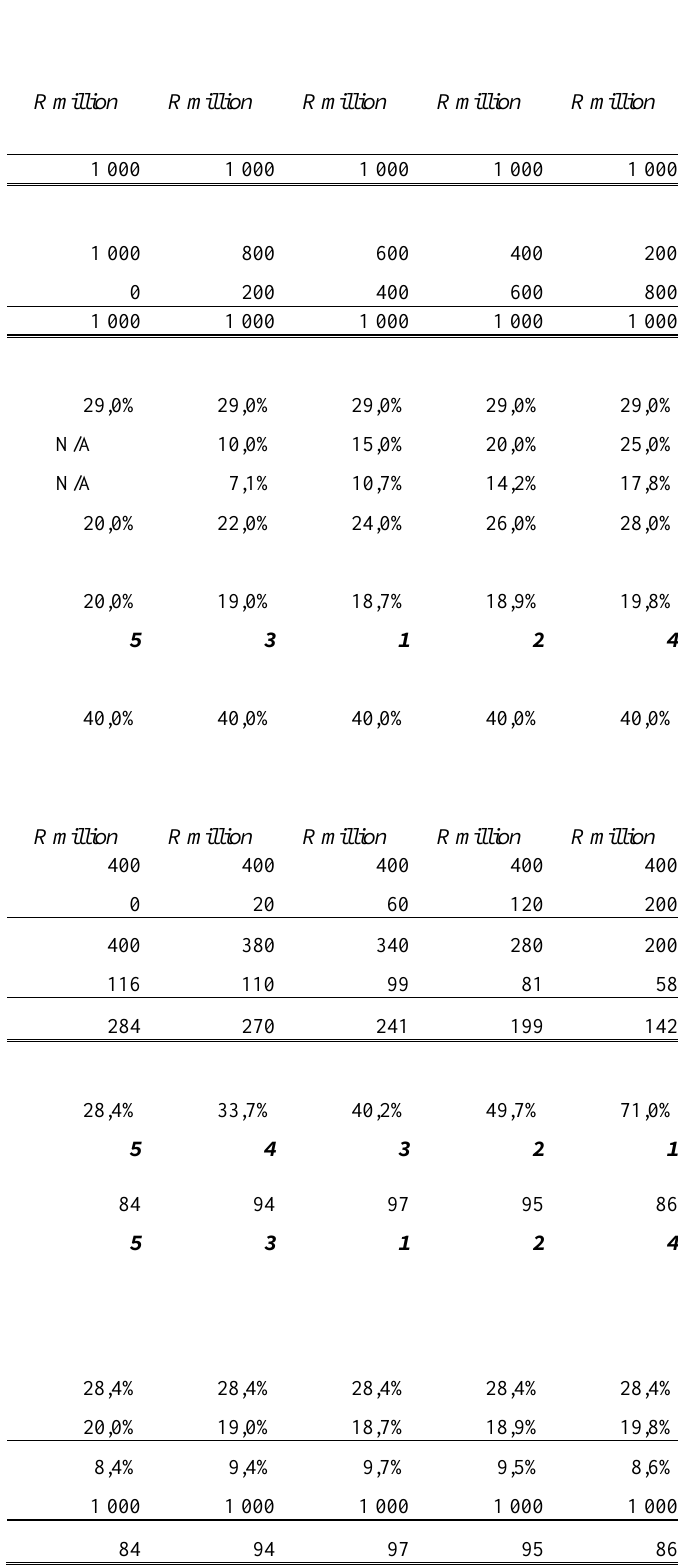
Table 1: ROE versus EVA at different levels of financial